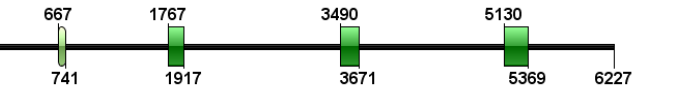
Table 2. IGF2 sequence of each species used in this study.